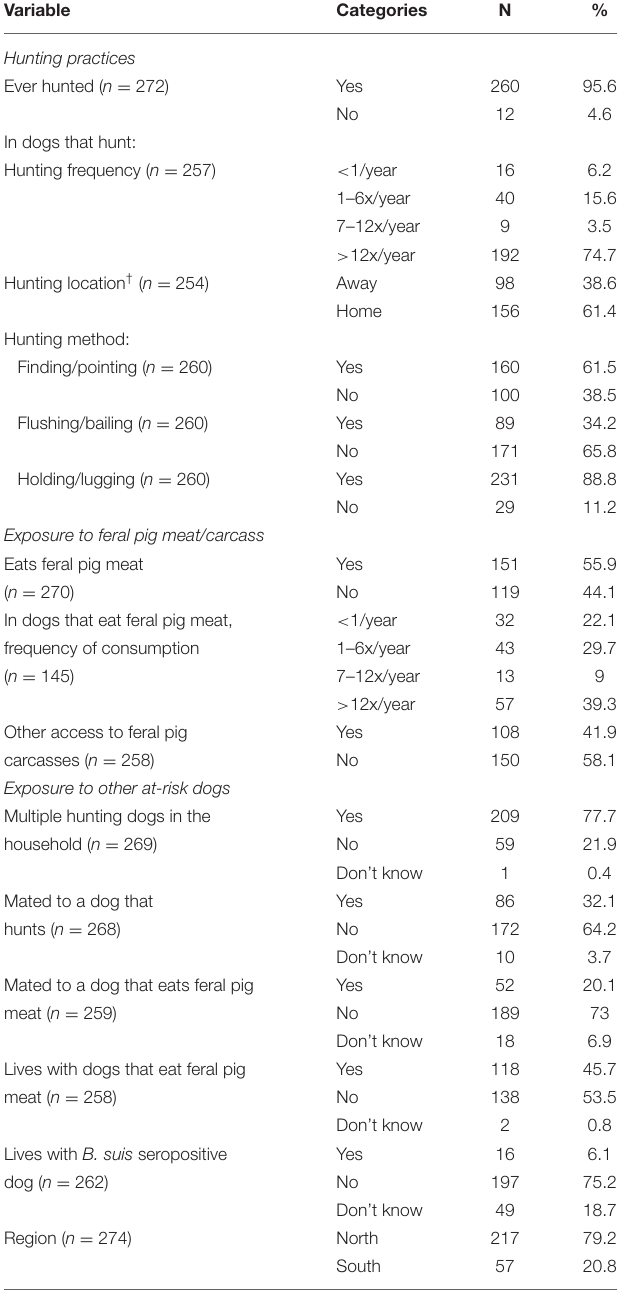
Table 4 . Male dogs were nearly four times more likely to